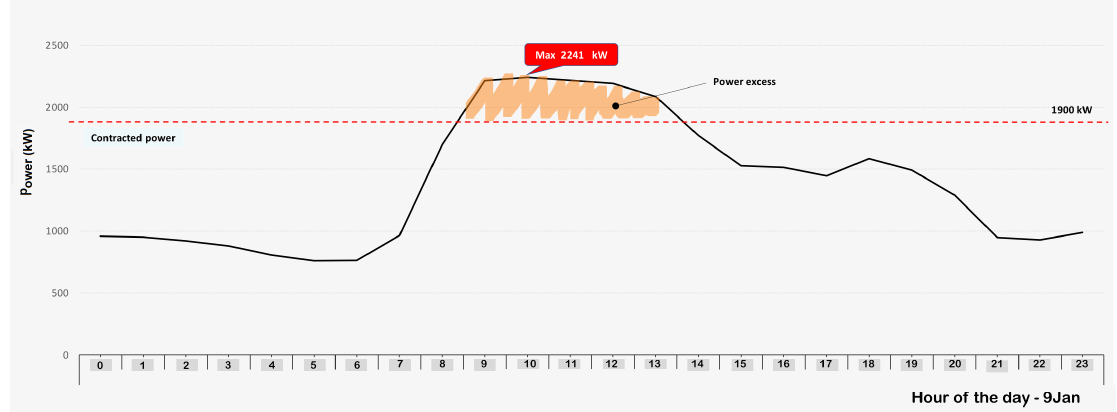
Figure 5. Typical load curve for a day of activity of the university analyzed (year 2018).